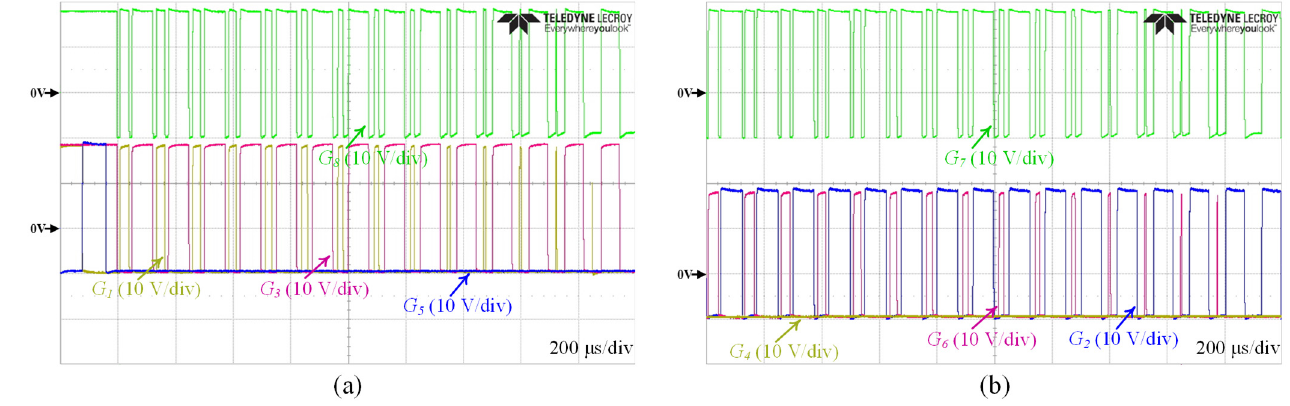
Figure 18. Experimental results of operation of S 7 and S 8 : ( a ) G 1 , G 3 , G 5 , and G 8 ; ( b ) G 4 , G 6 , G 2 , and G 7 .